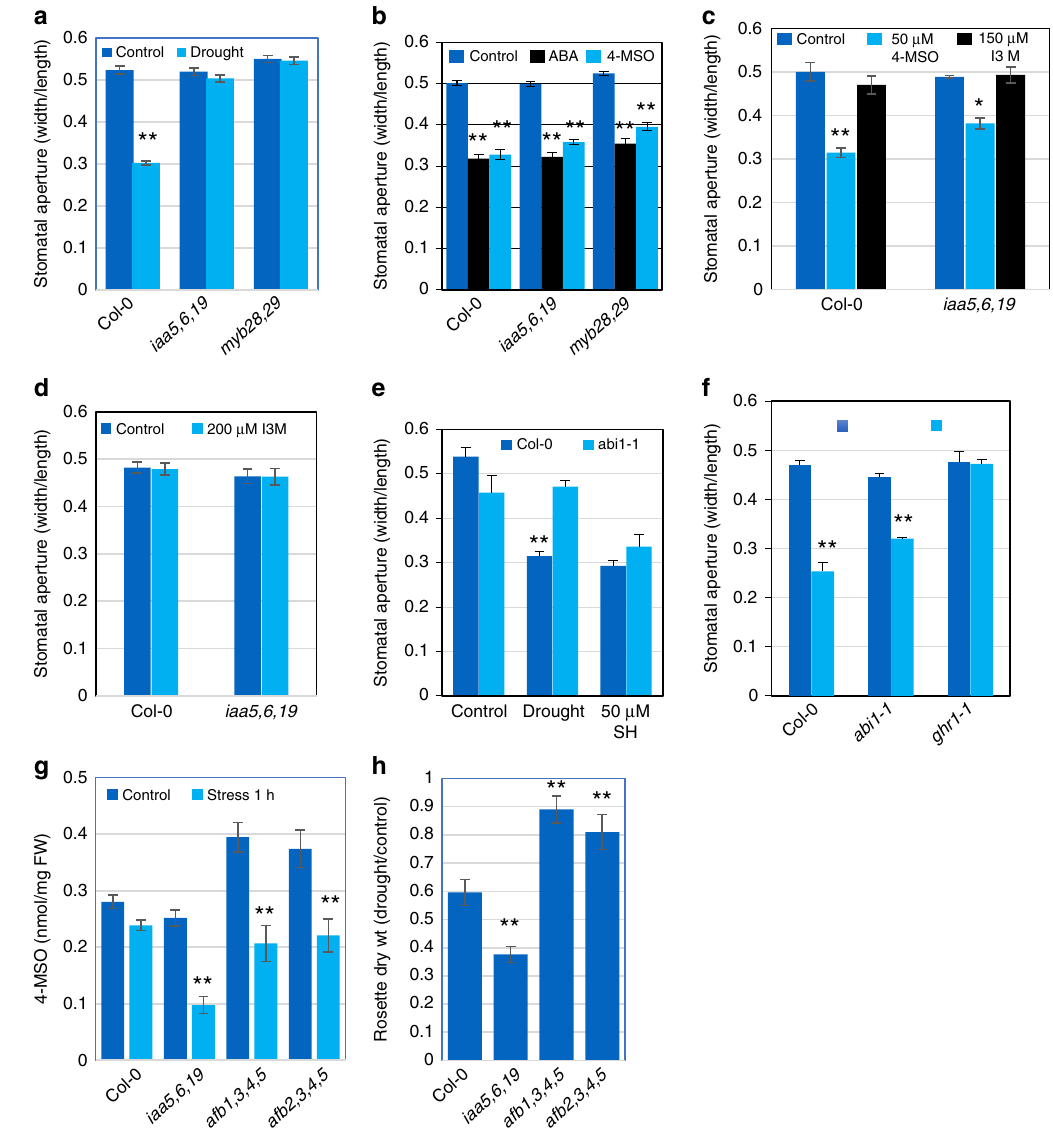
Fig. 4 Defects in stomatal regulation are responsible for decreased drought tolerance in glucosinolate de fi cient mutants. a Stomatal response to drought in Col-0, iaa5,6,19 and mybn28,29 lines. b Stomatal response to application of ABA and 4-MSO in Col-0, iaa5,6,19 and myb28,29 . c 4-MSO inhibits light- induced opening of stomata from dark-adapted plants while the indolic GLS I3M is ineffective. d Stomatal response to I3M in light-grown plants. e Response of the abi1-2 mutant to the aliphatic GLS sinigrin hydrate. f Response of the ghr1 mutant to 4-MSO, with abi1-2 as a control. Unlike Col-0 or aib1-2 , ghr1 does not respond to 50 μ M SH. g 4-MSO levels in tir1/afb mutants after 60 min desiccation treatment. h The tir1/afb mutants display increased tolerance to water withholding in pots. For stomatal closure experiments, n = 250 – 300 stomata from 6 different leaves from 3 different plants grown in the same chamber and growth condidtions. Results are presented as the means ± SE. Differences are signi fi cant at p < 0.05 ( ∗ ) and p < 0.01 ( ∗∗ ) by two-tailed Student ’ s t test. Source data are provided as a Source Data fi iaa5,6,19 in 7-day-old seedlings (Fig. 4g). After one hour of